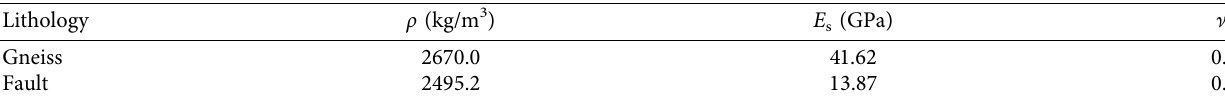
Figure 1: Curve of horizontal acceleration time history. Table 1: Rock mechanical